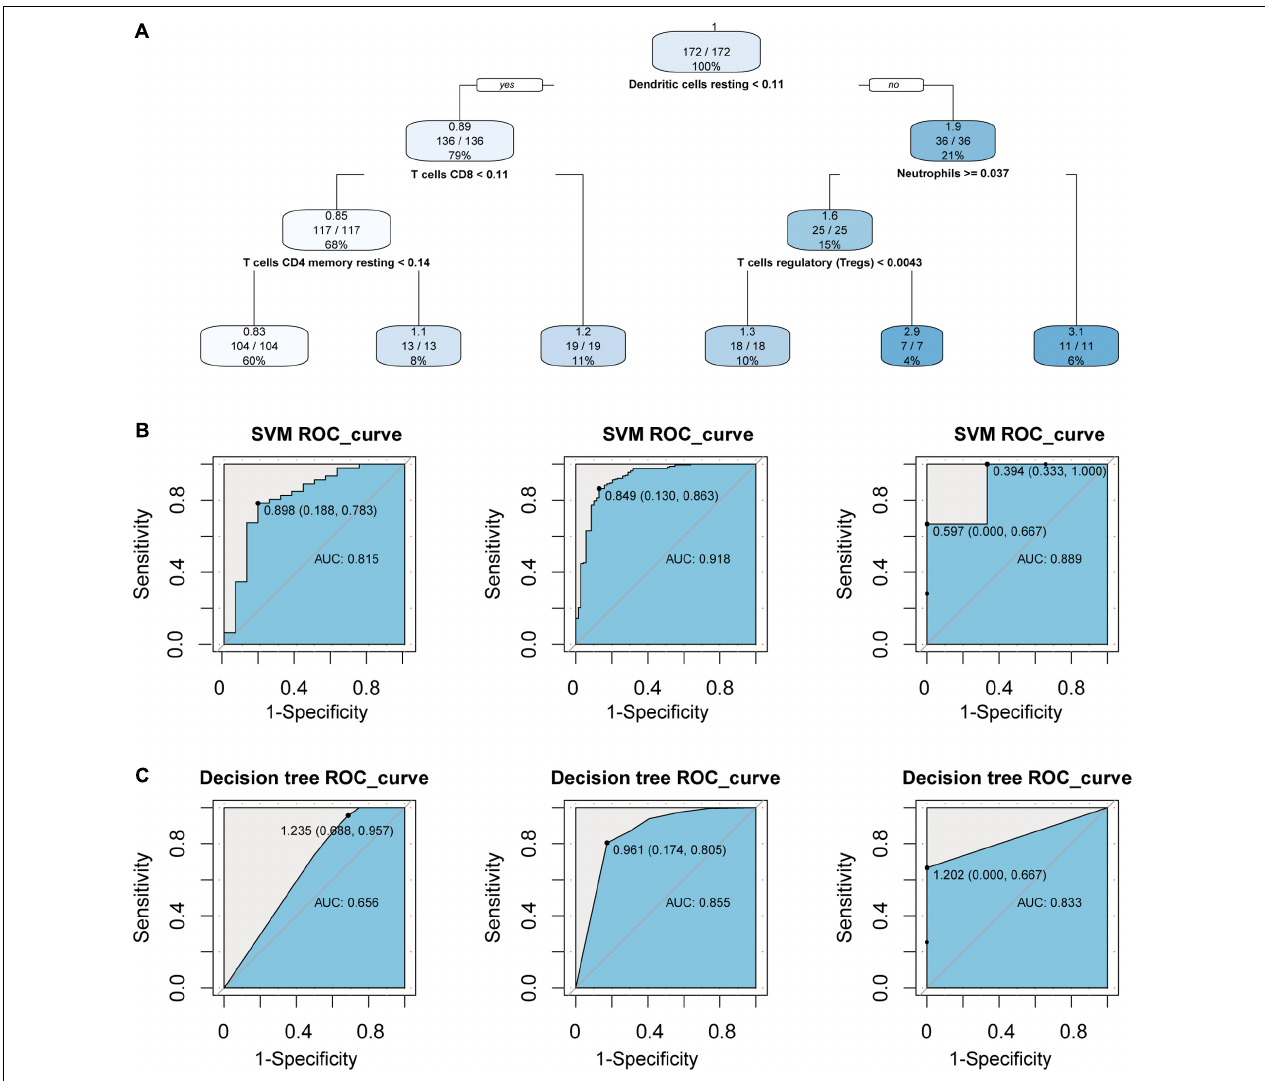
FIGURE 2 | Construct a classifier with significantly different distribution of immune cells. (A) This picture is the decision tree diagram of the decision tree classifier. (B) The ROC curve represents the area under curve (AUC) of the test set and validation set for SVM classifiers. (C) The same as in (B) but the Decision